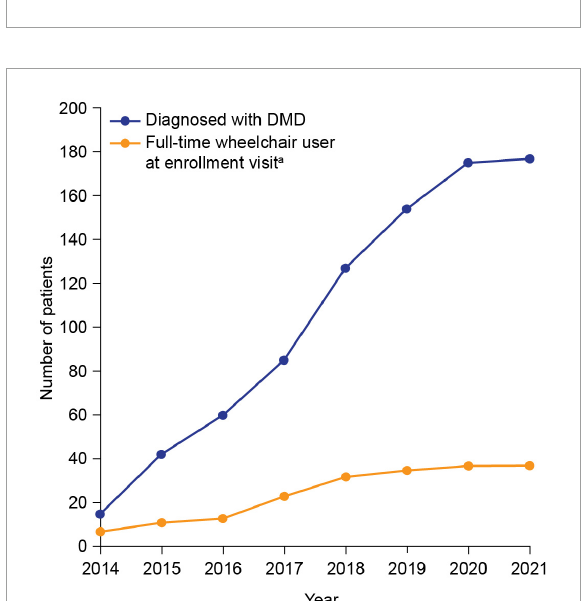
FIGURE2 Cumulative frequency of patients diagnosed with DMD since 2014 and patients who were full-time wheelchair users at enrollment. a The enrollment visit was the date when the patient visited the study site and had data recorded. DMD, Duchenne muscular